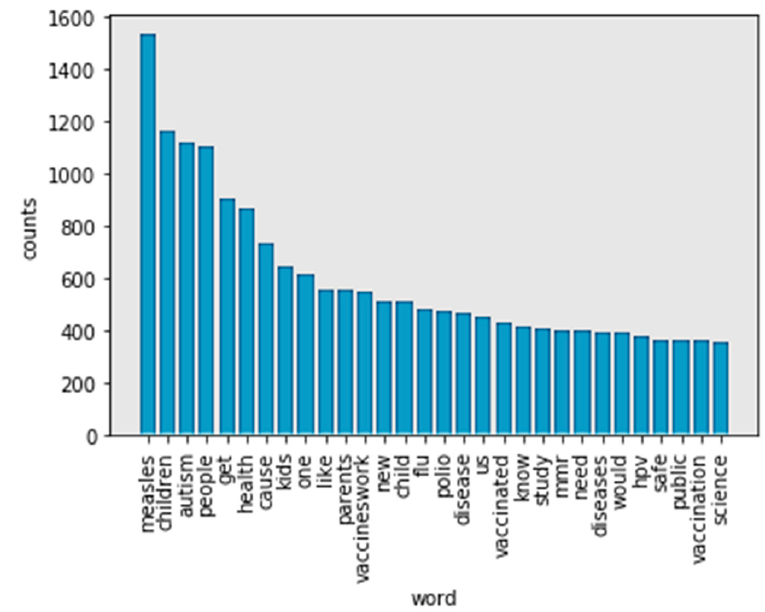
Figure 4. Top 30 frequency words in tokens without stop words.